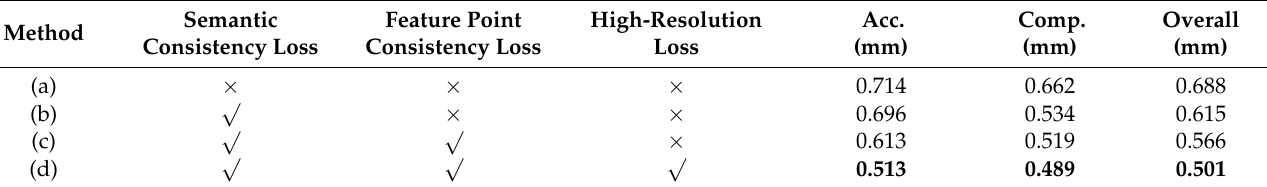
Table 2. Comparison of effect of each